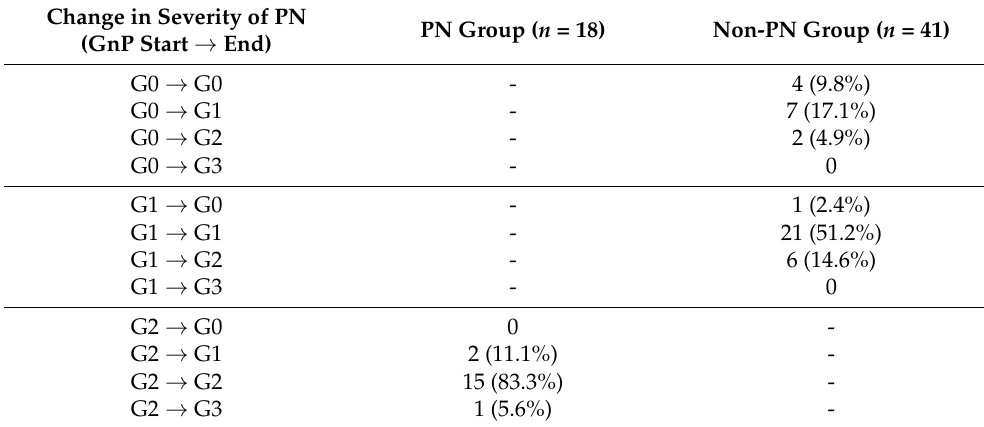
Table 5. Progression of PN during treatment with second-line GnP. Change in Severity of